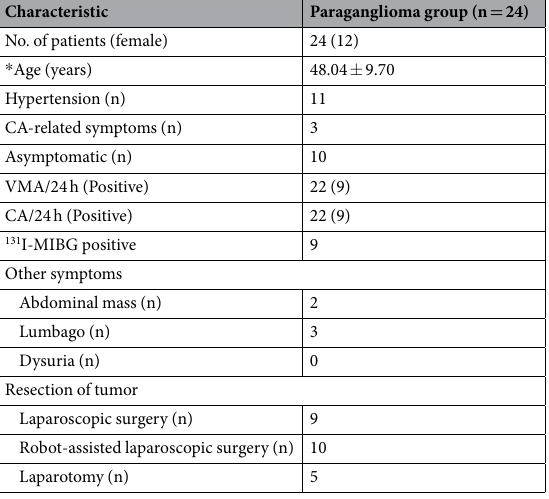
Table 1. Patient demographics and clinical characteristics. Note: * Values are mean values ± standard